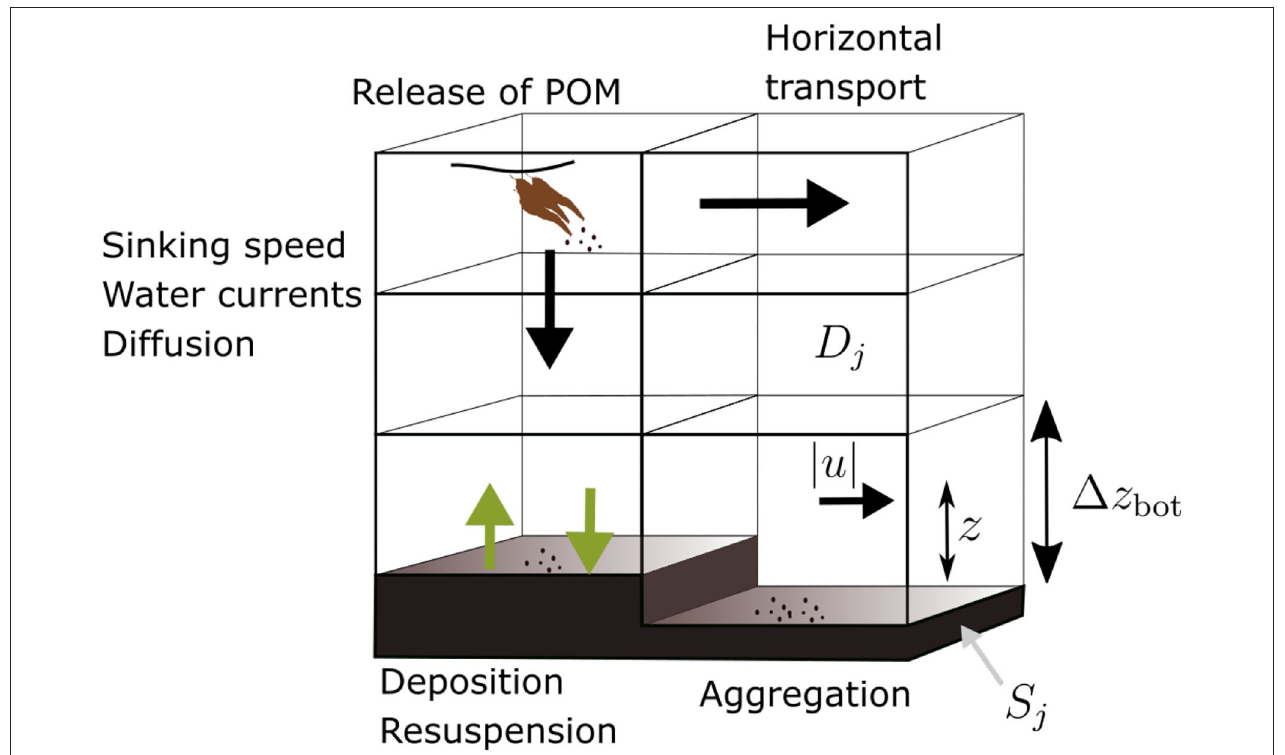
FIGURE 2 | Diagram of the POM transport model, illustrating the main processes: horizontal transport, vertical sinking, sedimentation, resuspension, and aggregation. The source is indicated (brown “kelp,” upper left), as well as the quantities | u | , z , and 1 z bot involved in calculation of the shear velocity (Equation